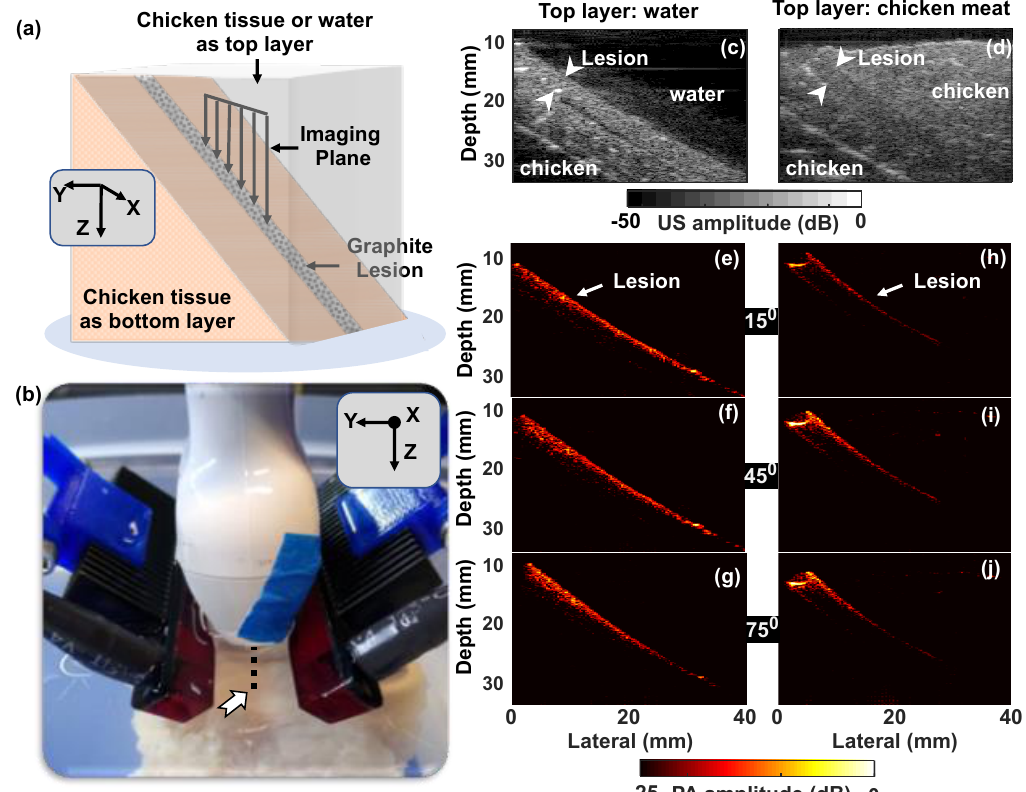
Figure 5. ( a ) Schematic of the tissue-mimicking phantom: Absorbing lesion (cylindrical in shape, 2 mm in diameter) placed on chicken tissue and arranged obliquely in the XZ plane. ( b ) Photograph of the experiment. The dotted line indicated by arrowhead shows the projection of lesion to the x -axis; ( c , d ) US image of the sample showing water top layer ( c ) or chicken layer ( d ) lesion and bottom chicken tissue in both cases; ( e – j ) PA intensity images captured using water as the top layer ( e – g ) or chicken tissue as the top layer ( h – j ), by choosing LED array directions: 15 ◦ ( e , h ), 45 ◦ ( f , i ), and 75 ◦ ( g , j ) with respect to the imaging plane.